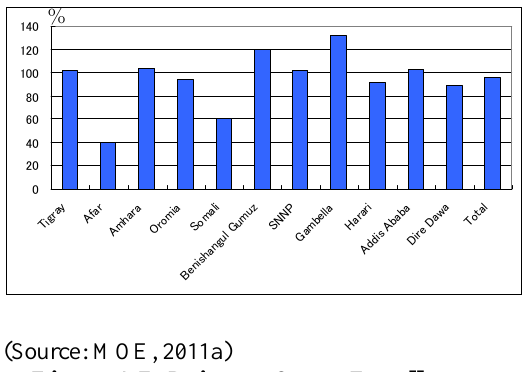
Figure 4-8: Secondary Gross Enrollment Rates by Region (2010/11)